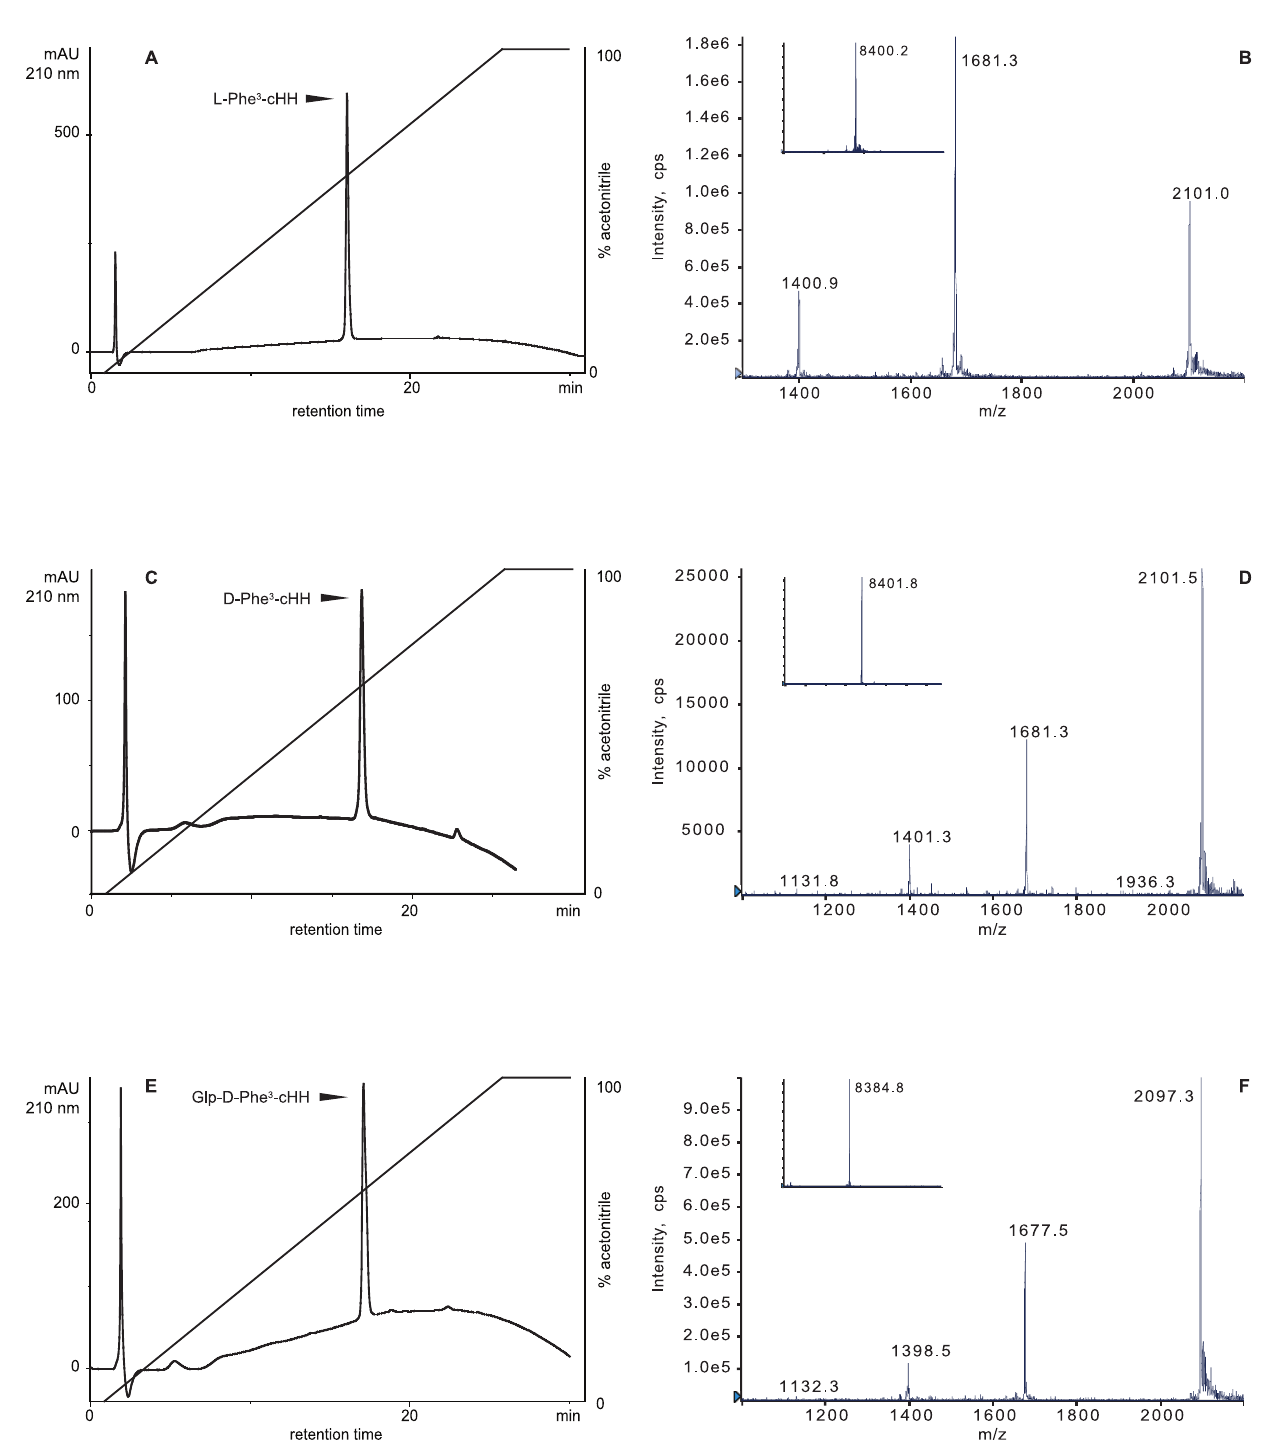
Figure 2. RP-HPLC profiles and ESI-MS spectra of the synthesized cHH isomers. Reverse Phase HPLC profiles of the purified refolded synthetic polypeptides and their corresponding ESI-MS multiply charged ion and deconvoluted spectra (insets): L-Phe 3 -cHH (A and B), D-Phe 3 -cHH (C and D), Glp-D-Phe 3 -cHH (E and F). Mobile Phase A: 0.1% TFA in water. Mobile Phase B: 0.1% TFA in MeCN. Gradient: 0–100% B over 25 min. Column: Gemini 5 C18 2.0 6 150 mm.